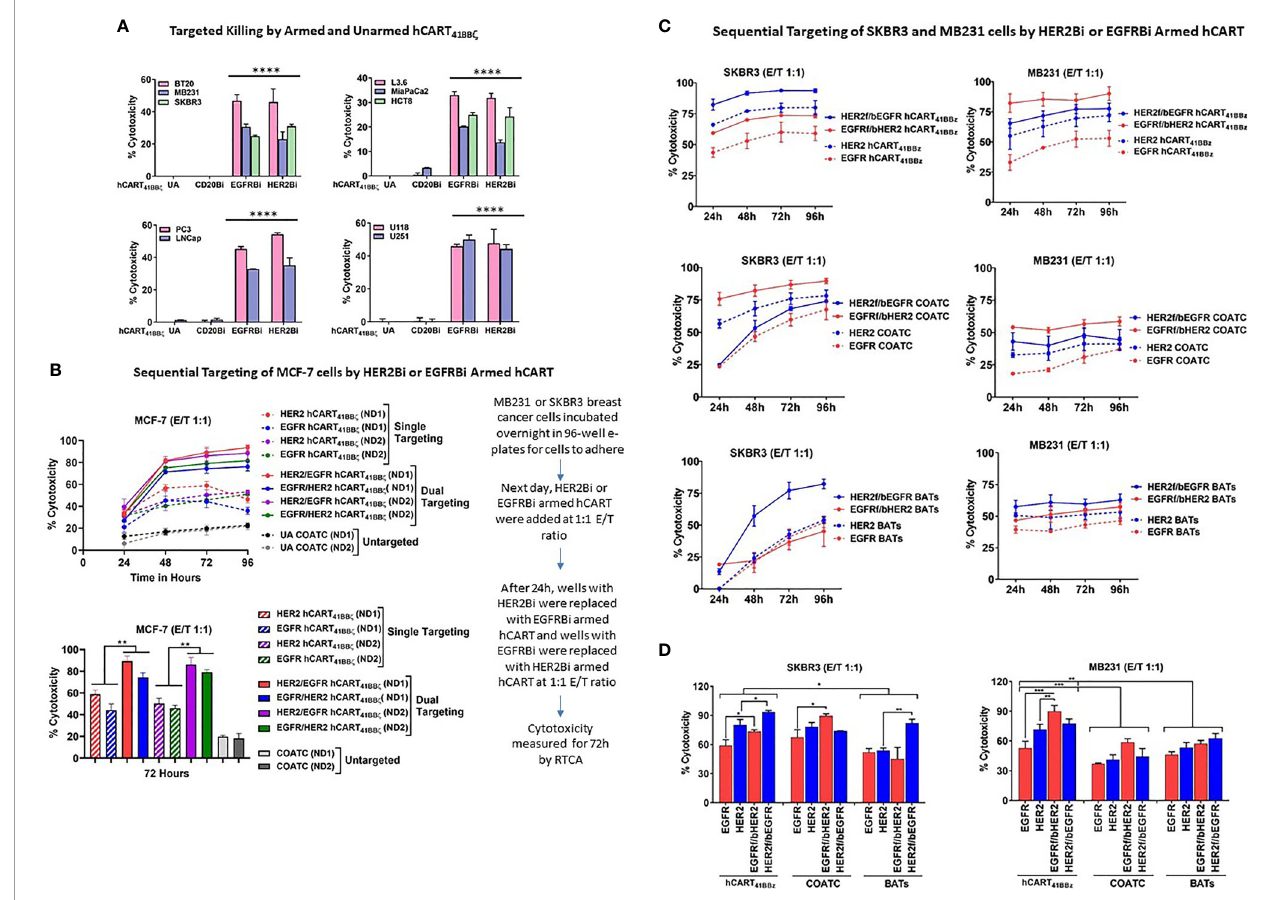
FIGURE 4 | hCART 41BB z : (A) Speci fi c Cytotoxicity by HER2 hCART 41BB z and EGFR hCART 41BB z Directed at Solid Tumor Cell Lines. The four panels show cytotoxicity of unarmed COATC (Control), CD20 hCART 41BB z (irrelevant control), EGFR hCART 41BB z and HER2 hCART 41BB z in 51 Cr release assay at E:T of 10:1. Cytotoxicity was measured against breast (Upper left), pancreas/GI (Upper right), prostate (Lower left) and glioblastoma (Lower right) cell lines. Data is presented as mean ± SD (n=3) and analyzed using Two-way ANOVA and Turkey ’ s multiple comparisons test (****p < 0.00001). (B) Sequential Targeting of MCF-7 with HER2 hCART 41BB z and EGFR hCART 41BB z . Upper panel shows the sequential cytotoxicity against MCF-7 cell line with either HER2 hCART 41BB z followed by (f/b) EGFR hCART 41BB z or EGFR 41BB z (f/b) HER2 hCART 41BB z using RTCA up to 96 hours at E:T of 1:1. The dashed lines denote single antigen targeting by HER2 hCART 41BB z or EGFR hCART 41BB z and solid lines show the double sequential killing mediated by effectors from 2 normal donors (ND1 =Normal Donor 1 and ND2 = Normal Donor 2). Lower panel shows the signi fi cant killing at 72 hours with sequential antigen targeting by HER2 hCART 41BB z f/b EGFR hCART 41BB z or EGFR hCART 41BB z f/b HER2 hCART 41BB z of MCF-7 compared to single antigen targeting by HER2 hCART 41BB z (p<0.007) and EGFR hCART 41BB z (p<0.003). Data is presented as mean ± SD (n=3) and analyzed using Two-way ANOVA and Turkey ’ s multiple comparisons test (**p < 0.001*). Right panel shows the sequential targeting schema. (C) Show Sequential Targeting of Two Antigens in SKBR3 and MB231 Cell Lines. The hCART 41BB z induced signi fi cantly higher cytotoxicity against SKBR3 cells by sequential targeting of HER2 f/b EGFR (p<0.03) or EGFR f/b HER2 (p<0.02) compared to single antigen targeting. COATC and BATs also showed signi fi cantly enhanced killing by sequential targeting of EGFR f/b HER2 (p<0.03), HER2 f/b EGFR (p<0.004) compared single antigen targeting on SKBR3 cell line (Left panels of C and D). Signi fi cantly higher cytotoxicity after sequential targeting of EGFR f/b HER2 by hCART 41BB z compared to single antigen targeting of HER2 (p<0.001) or EGFR (p<0.0002) was observed for MB231 cells (Right panels of C, D ). Data is presented as mean ± SD (n=3) and analyzed using Two-way ANOVA and Turkey ’ s multiple comparisons test (***p < 0.0001, **p < 0.001, *p <